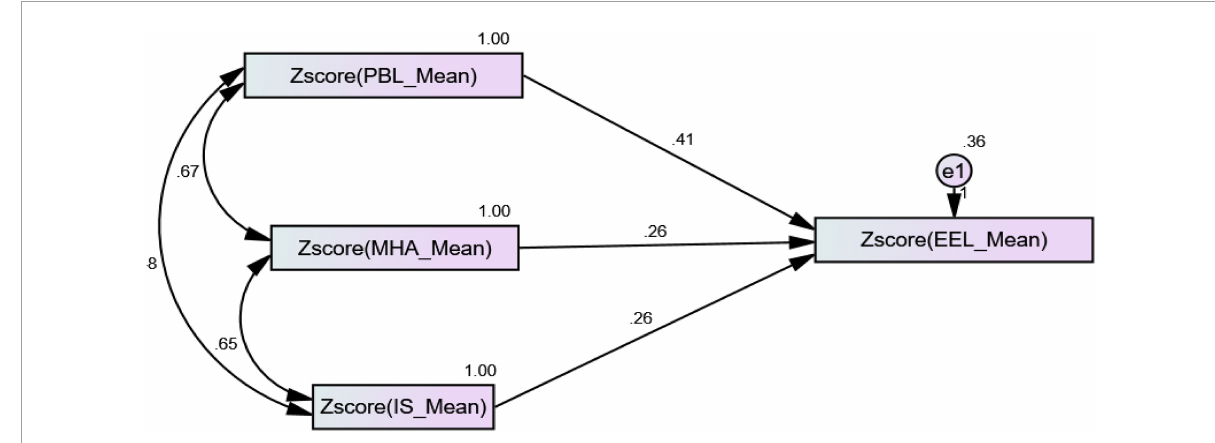
FIGURE2 Structural equation modeling (SEM) results of direct effects.